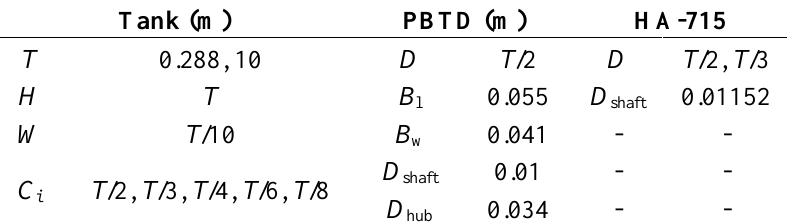
Figure 1. Computational domain, grid distribution, and schematic of the stirred tank. Table 2. Dimensions of domain and properties of materials used in this study.